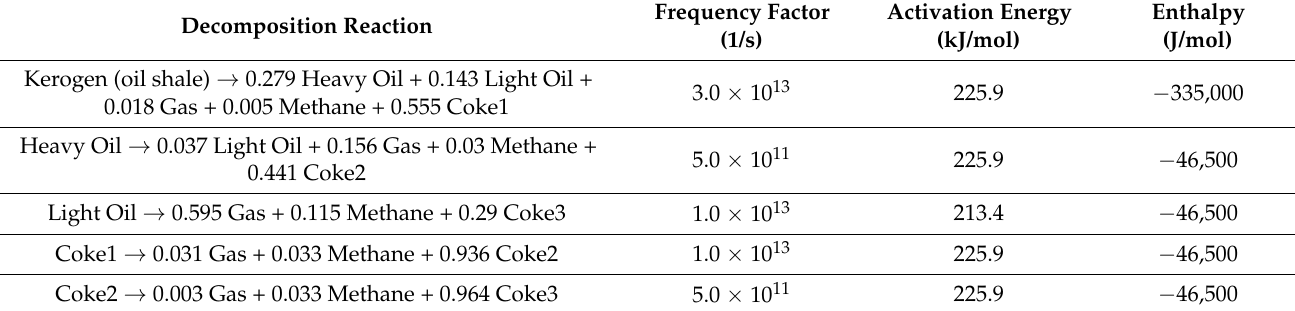
Table 1. Kinetic data for chemical reactions